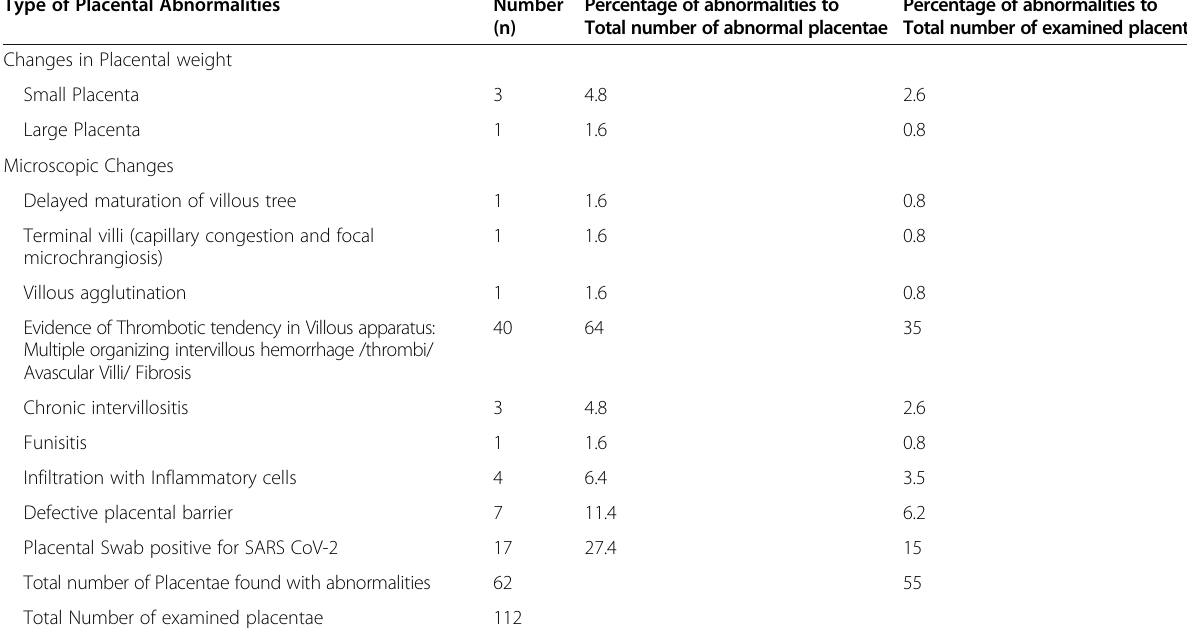
Table 4 Placental abnormalities in placentae of COVID-19 positive mothers in retrieved studies Type of Placental Abnormalities